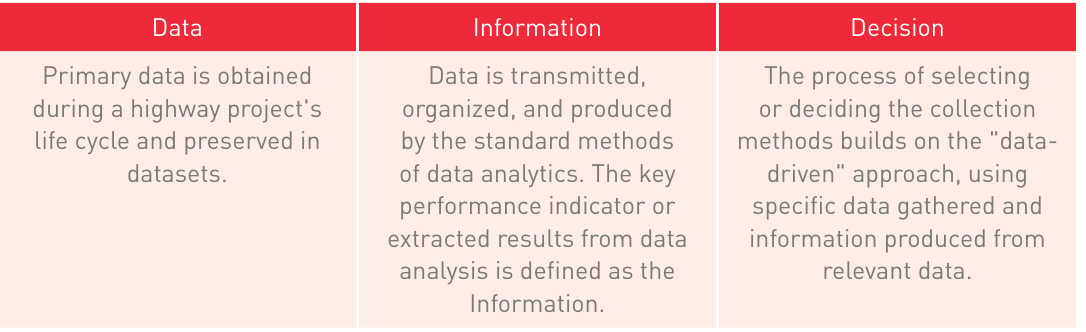
Information Hierarchy Entities Data